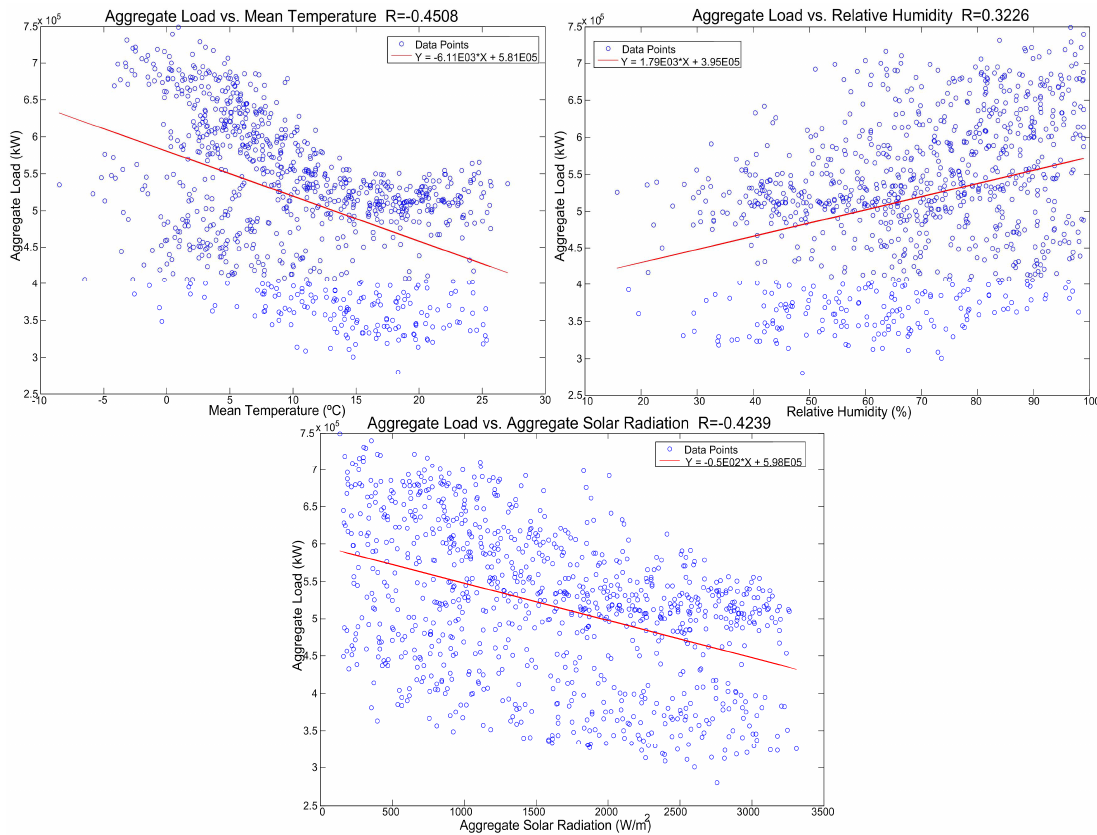
Figure 3. Linear regression of the aggregated load on mean temperature, relative humidity and solar radiation. Y -axis shows the aggregated demand (kW) and x -axis, the mean temperature (°C), relative humidity (%) and solar radiation ( w / m 2 ). The correlation coefficient between the aggregated demand and each of the variables is indicated in each